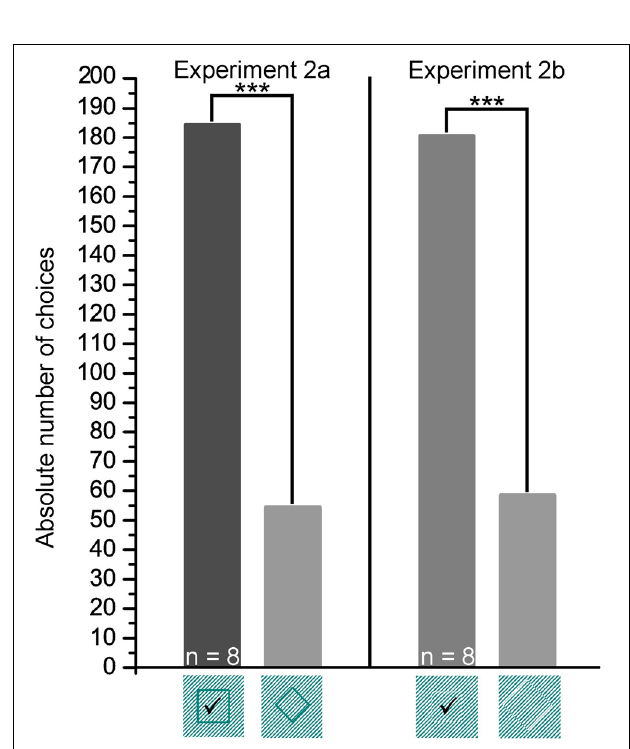
FIGURE 8 | Experiment 2. Shown are the group results for the transfer trials (2a and 2b). p > 0 . 05 not significant, p ≤ 0 . 001 significant ( ∗∗∗ ). The correct choice is marked by a